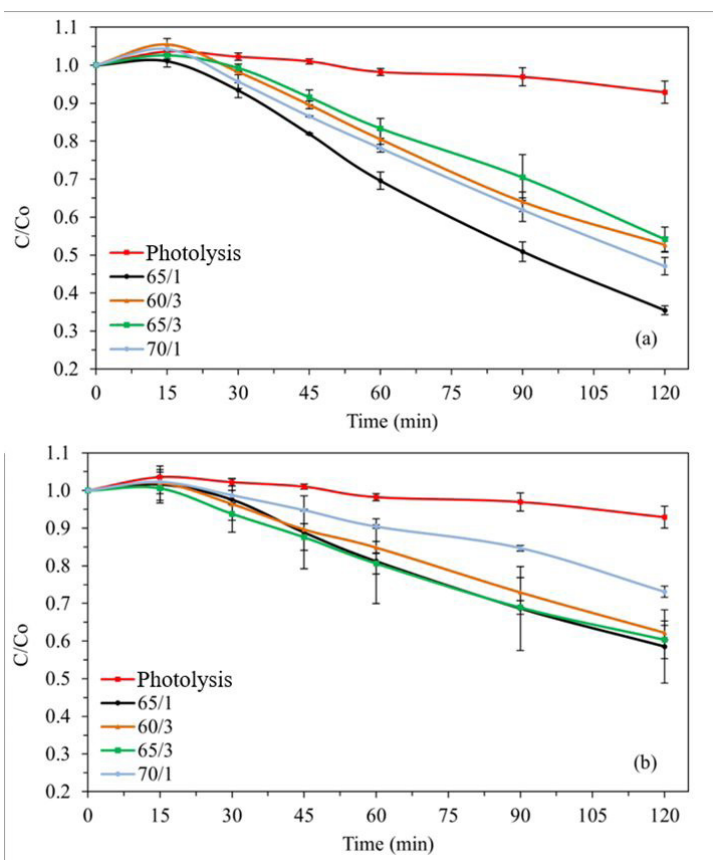
Figure 9. Rhodamine B (5 mg L -1 ) photo-decolorization as a function of time in the presence of heat-treated ZnO ceramics at (a) 800 °C/ 2h and (b) 1000 °C/